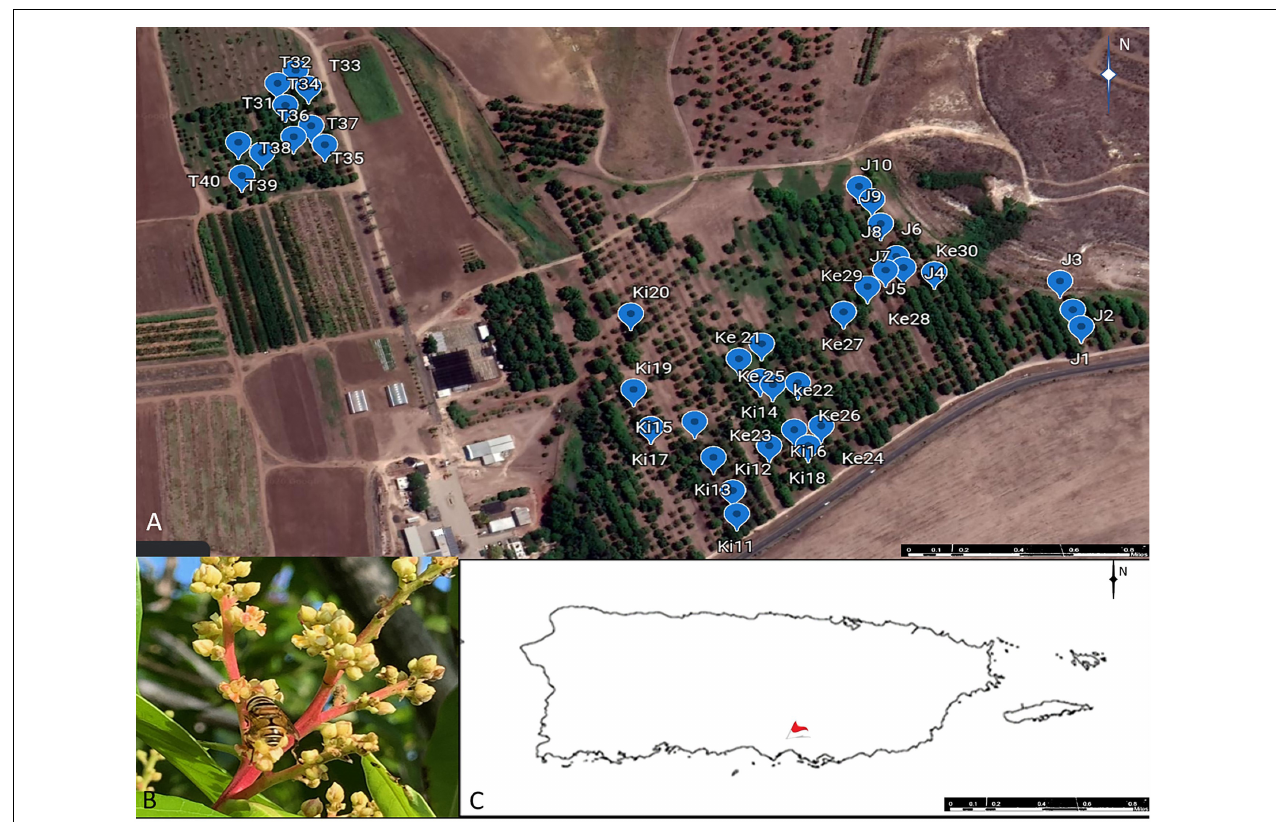
FIGURE 1 | (A) Layout of the Juana Díaz Agricultural Experimental Station indicating the location of the mango germplasm and the four fields [Julie (J), Keitt (Ki), Kent (Ke), Tommy Atkins (T)] used in this study. (B) Palpada vinetorum visiting inflorescences of the Julie fields. (C) Location of the Agricultural Experiment